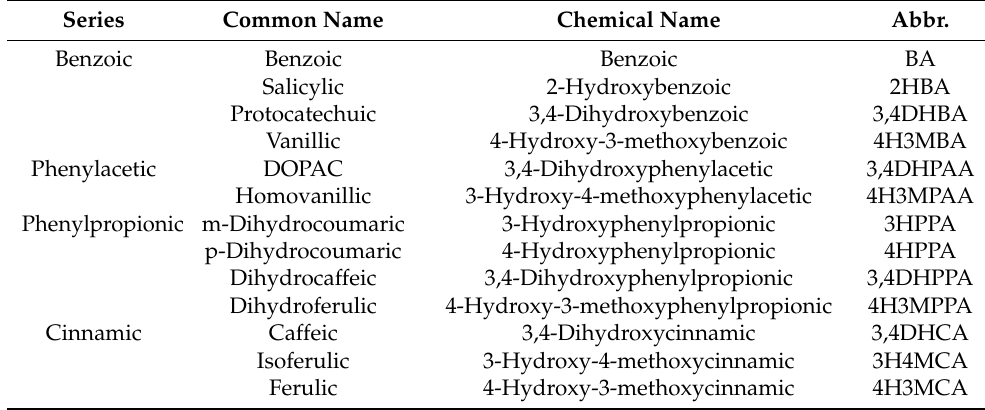
Table 1. Phenolic acids used in this